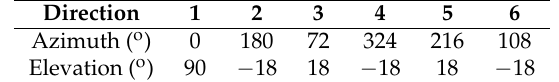
Table 1. Reference sound source directions during the localization performance test.